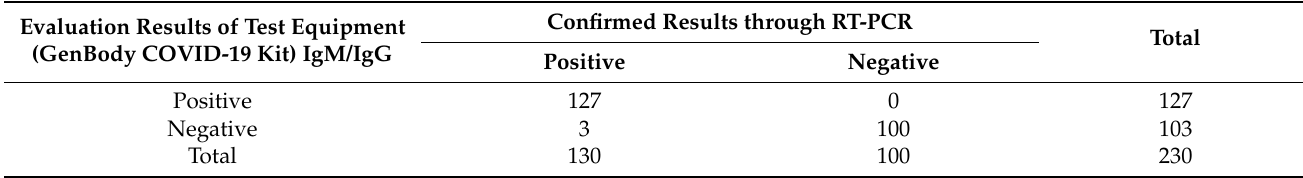
Table 2. Results of the tests using the GenBody™ COVI040